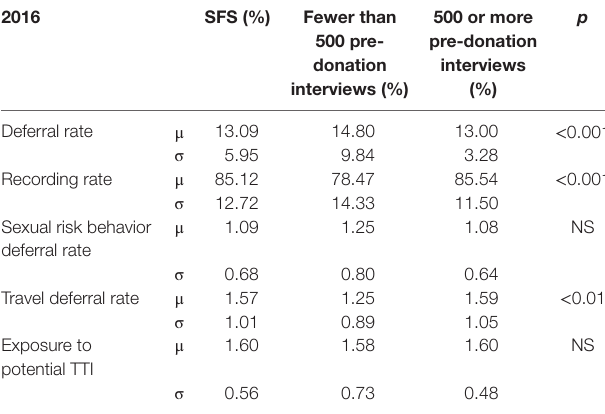
TaBle 4 | Comparison of deferral rates between health professionals (HPs) who conducted fewer than or at least 500 pre-donation interviews during 2016.